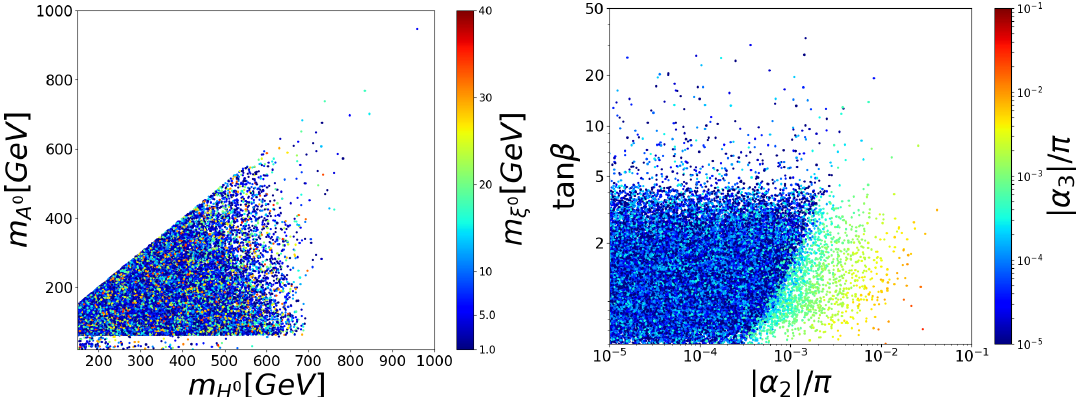
Figure 4 . The allowed scalar mass regions satisfying constraints from scalar potential and Higgs